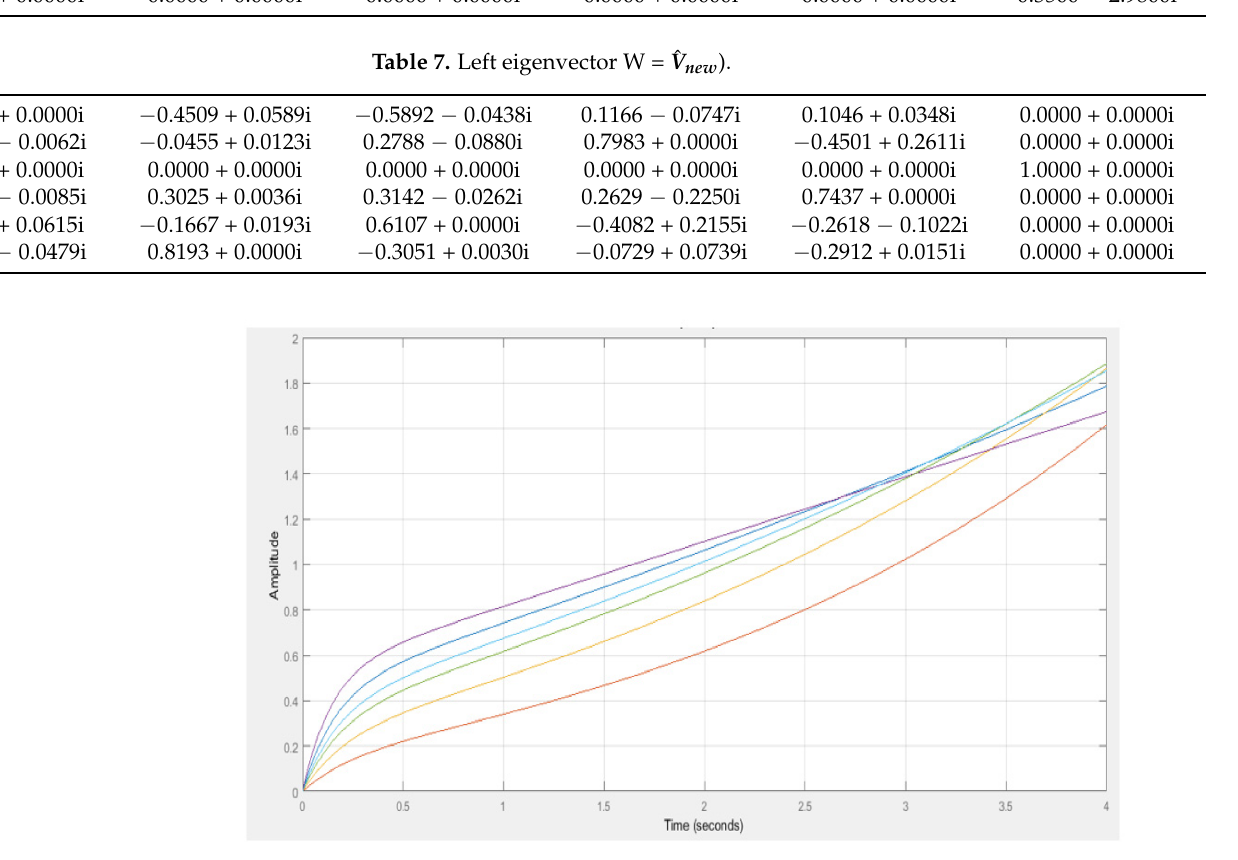
Figure 8. Step response of uncompensated 6 bus Nigerian 330 kV Eastern Grid